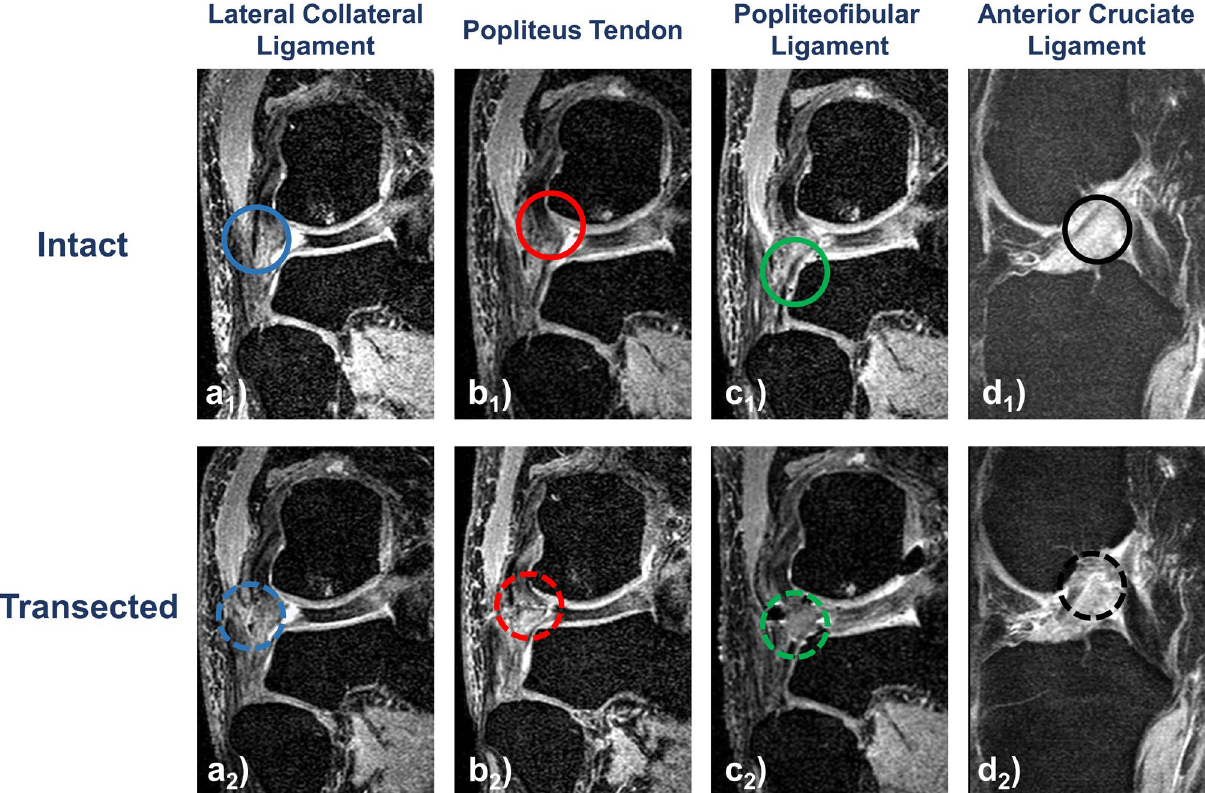
Figure 5. Morphologic MR images of the graded injury model. Visualized are representative coronal ( a – c ) and sagittal ( d ) images centred on the respective structure before (“intact” [ a 1 – d 1 ], full circles) and after sequential surgical transection (“transected” [ a 2 – d 2 ], dotted circles). 3D proton density-weighted fat-saturated sequence. Color-coding: lateral collateral ligament—blue, popliteus tendon—red, popliteofibular